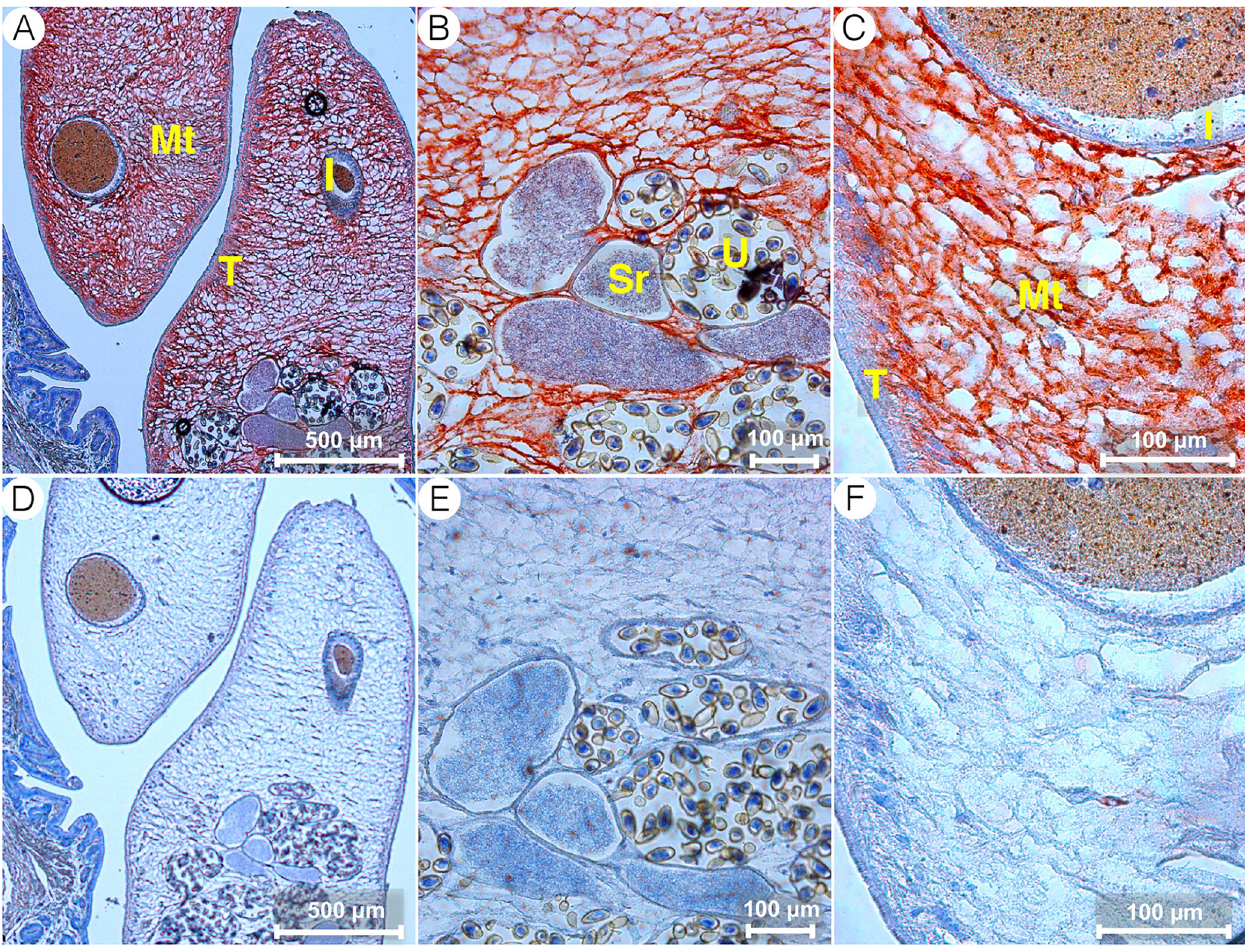
Fig 5. CsSBAT localization in Clonorchis sinensis adults using immunohistochemical staining. A–C, mouse anti-CsSBAT immune serum. D–F, normal mouse serum. I, intestine; Mt, mesenchymal tissue; Sr, seminal receptacle; T, tegument; U, uterus.